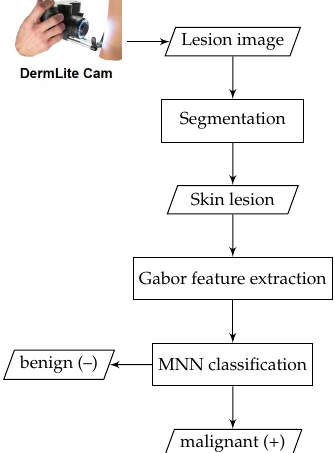
Figure 1. Block diagram of the proposed CAD system for melanoma